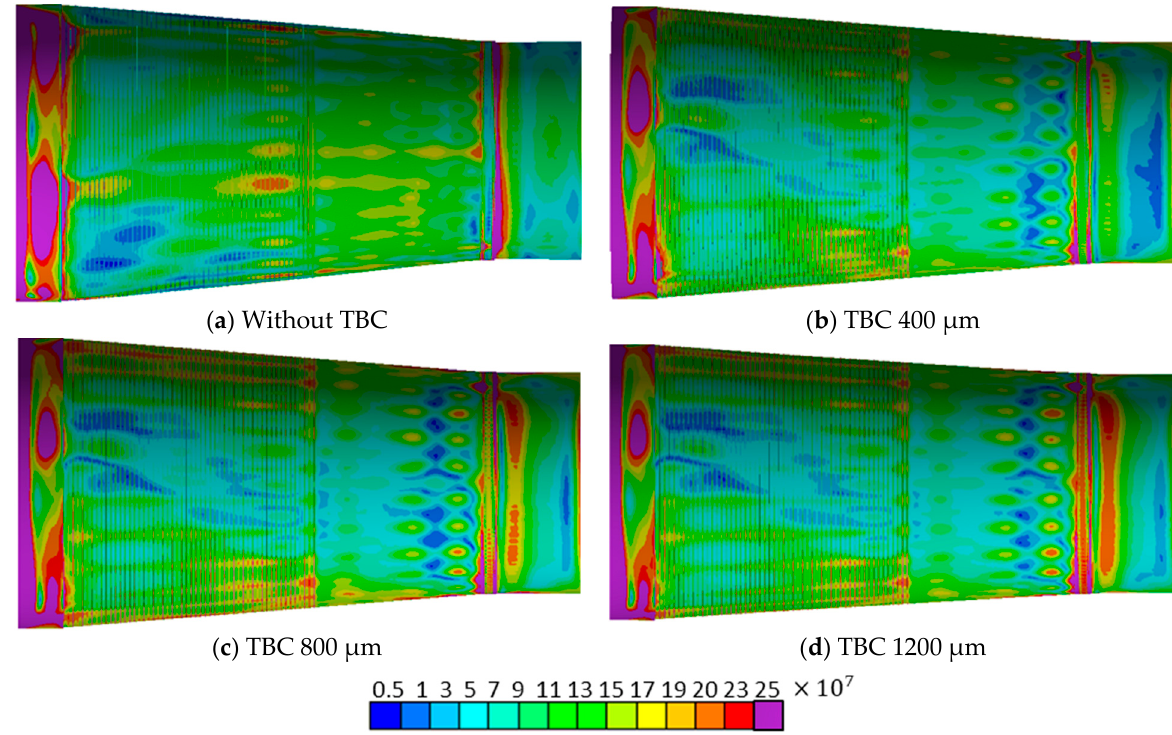
Figure 19. Surface stress (×10 7 Pa) distribution on the combustor liner based on TBC thickness. Creep life prediction of the inner surface Creep life prediction of the outer surface